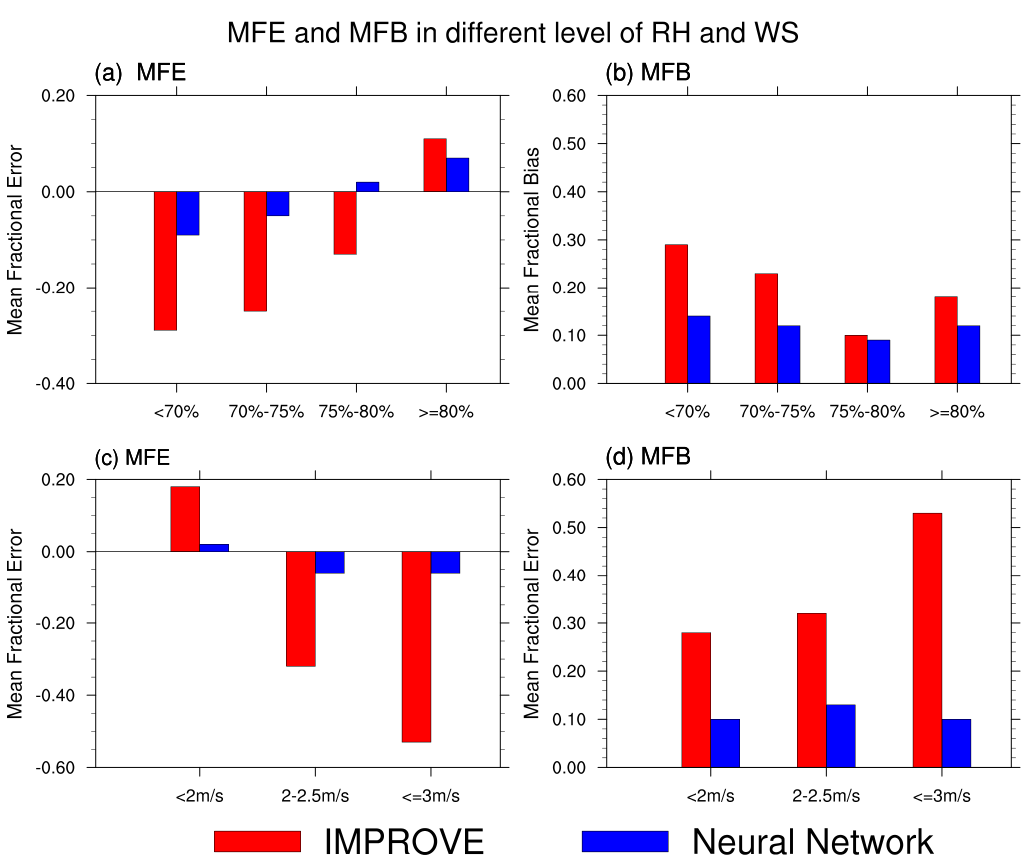
Figure 11. MFE and MFB derived from visibility of different surface relative humidity and wind speed levels by Interagency Monitoring of Protected Visual Environments (IMPROVE) and neural network